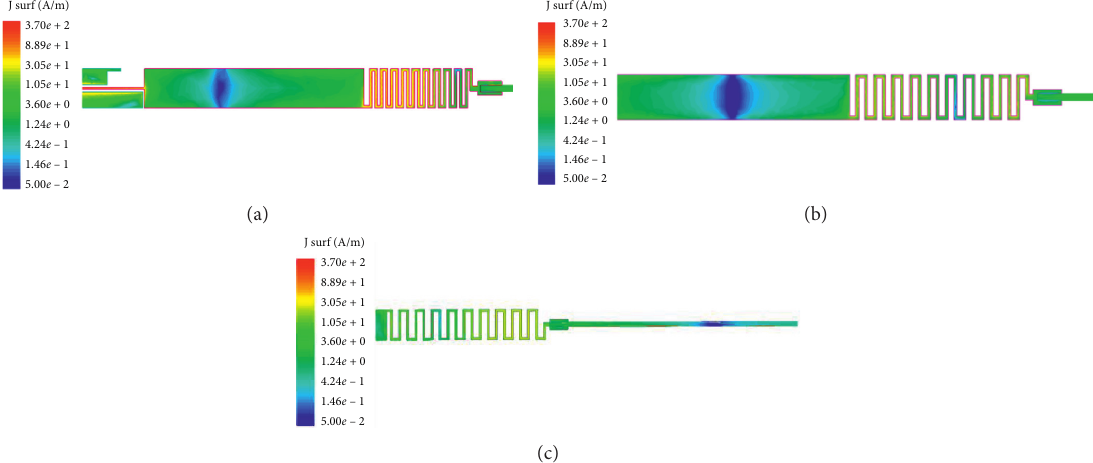
Figure 3: Simulated current distributions at various lengths of the meander line: (a) d